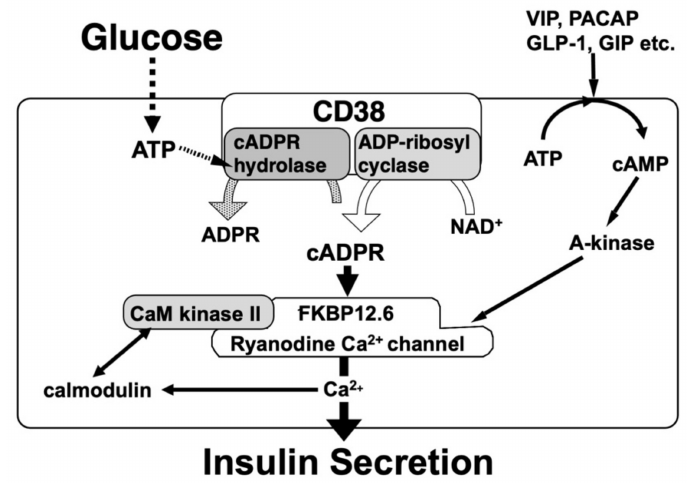
Figure 5. Possible model for glucose-induced insulin secretion via the CD38-cADPR signal system and its enhancement by CaM kinase II and A-kinase. CaM kinase II and A-kinase phosphorylate and activate RyR in pancreatic β -cells to secrete insulin much more. Peptide hormones such as vasoactive intestinal peptide (VIP), pituitary adenylate cyclase-activating peptide (PACAP), glucagon-like peptide-1 (GLP-1), and glucose-dependent insulinotropic polypeptide/gastric inhibitory polypeptide (GIP) activate adenylate cyclase (A-kinase) to increase cAMP. As a result, RyR Ca 2+ channel is phosphorylated and sensitized/activated for cADPR-induced Ca 2+